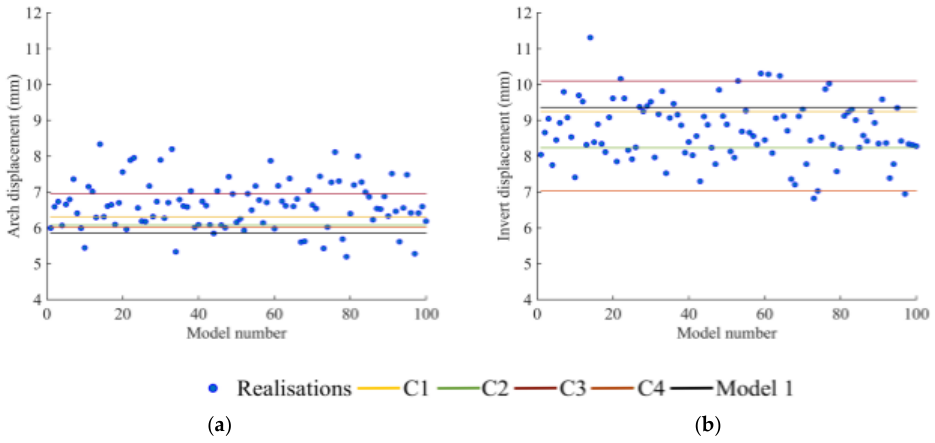
Figure 10. Representation of the displacements (in mm) obtained for all of the analysed models (102), the deterministic model 1, cluster 1 (C1), 2 (C2), 3 (C3), and 4 (C4) of model 2, and the 100 realisations, in: ( a ) the centre of the tunnel arch; and ( b ) the centre of the tunnel invert.